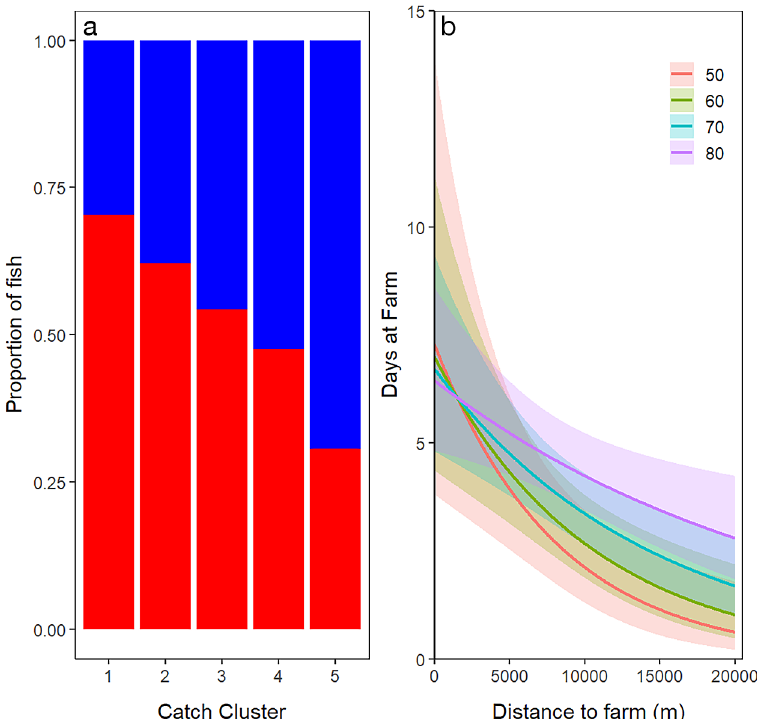
Fig. 4. (a) Proportion of cod from each catch cluster that were recorded at a salmon farm on at least 1 d (red: proportion observed at a farm; blue: propor- tion not observed at farm) and (b) model results (solid lines show the model results with shaded areas representing the modeled uncertainty of the fixed effects) showing the modeled number of days fish would be observed at a farm as a function of distance from release point to the farm. Given that there was an interaction between predicted days at a farm and fish length, model results are shown for 4 example fish of 50, 60, 70 and 80 cm (most common lengths